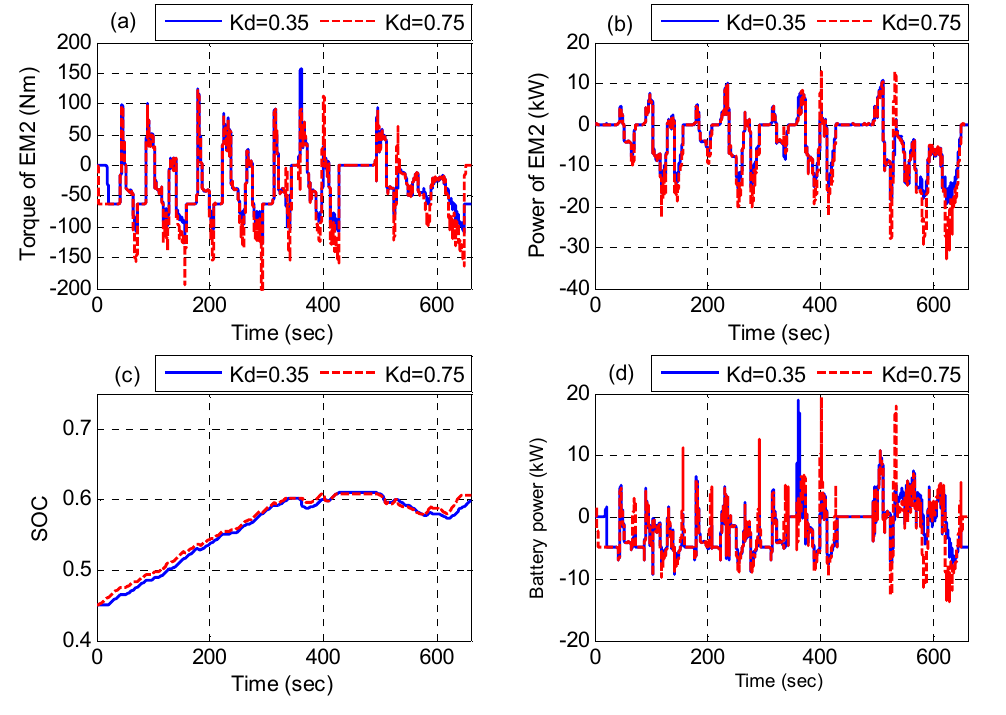
Figure 10. Performance of EM2 and battery at (cid:1837) Modified Prius